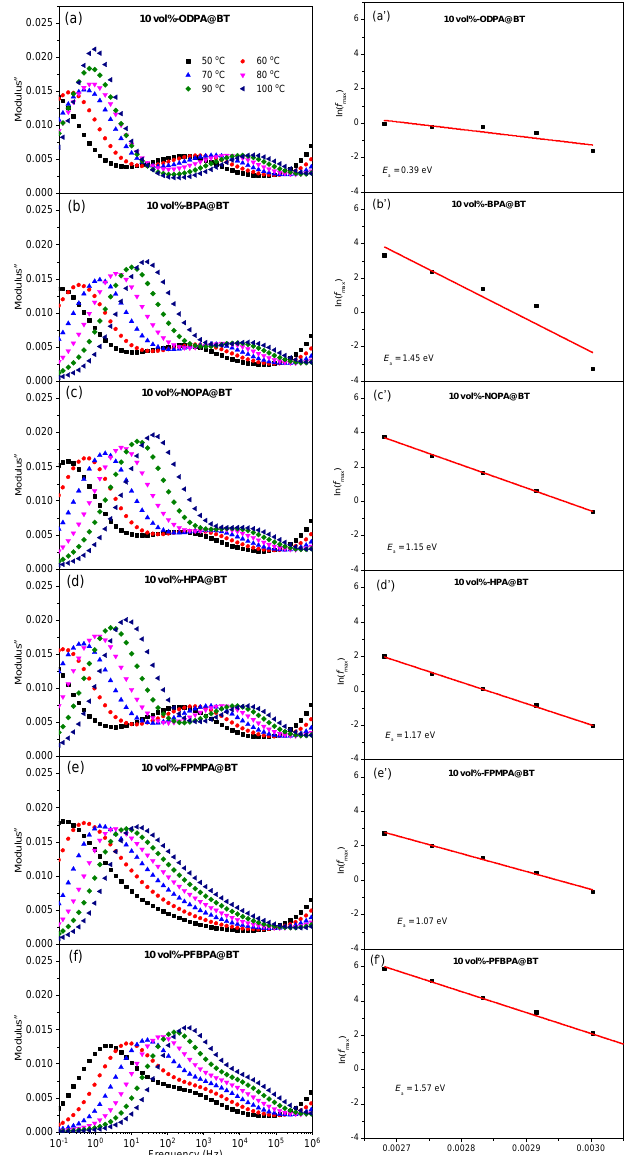
Figure 5. Frequency dependence of the imaginary electric modulus ( a – f ) and 1/T Arrhenius plots ( a ′– f ′ ) of the P(VDF-HFP)-based nanocomposites with 10 vol% of modified BT nanoparticles.